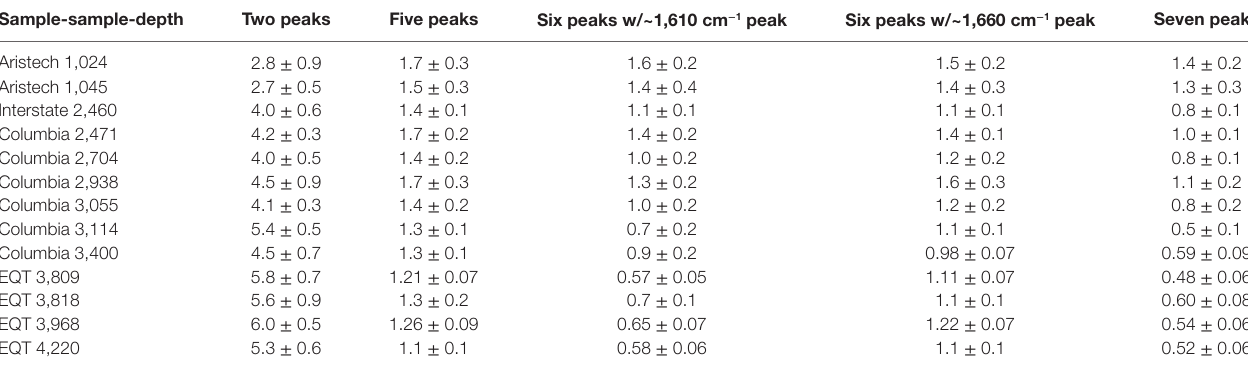
Table 3 | Number of peaks selected and resultant χ 2 values.